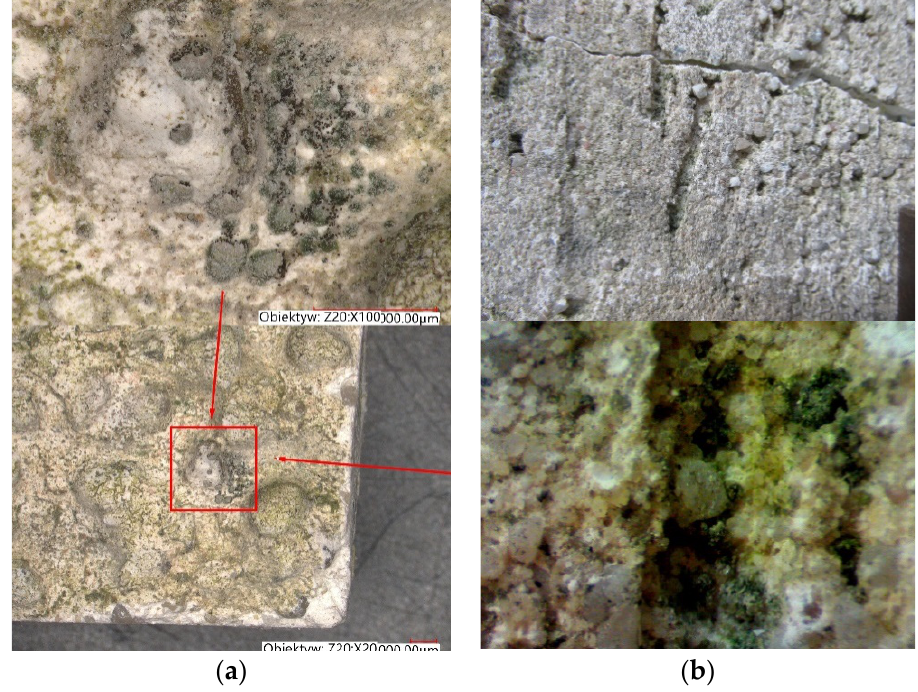
Figure 4. Development of biocorrosion on different textures after 5 years of operation (magnification: 20x and 100x) (author’s archives). ( a ) Dashed plaster. ( b ) Filled plaster. 20x and 100x) (author’s archives). ( a ) Dashed plaster. ( b ) Filled